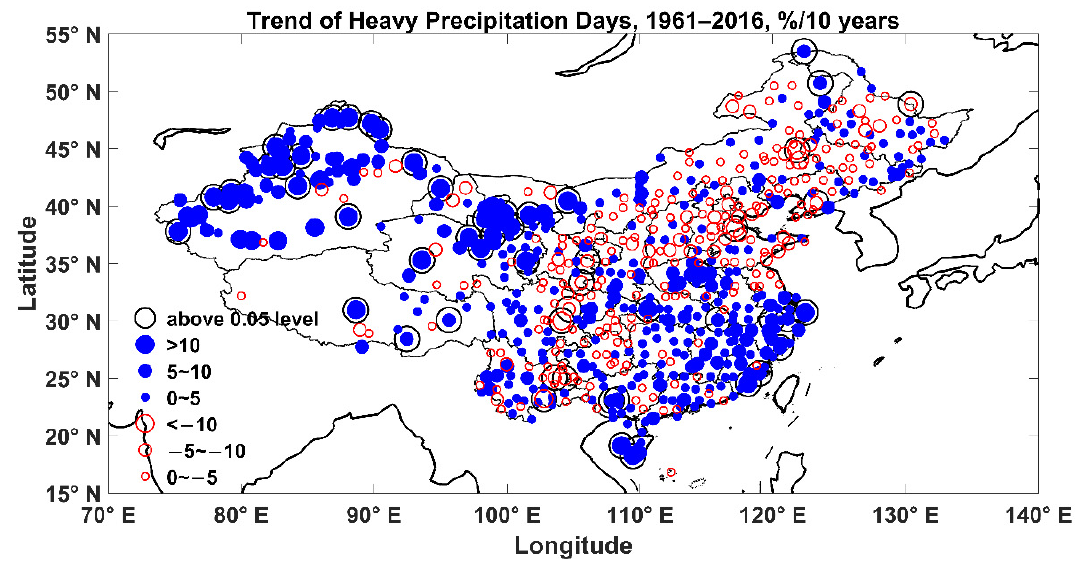
Figure 10. The spatial distributions about the temporal trends of heavy precipitation occurrence days at 635 ground stations in at 635 ground stations in China.